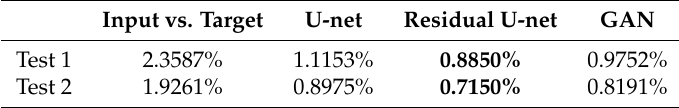
Table 3. Error rate for independent test sets at map scale 1:15,000.